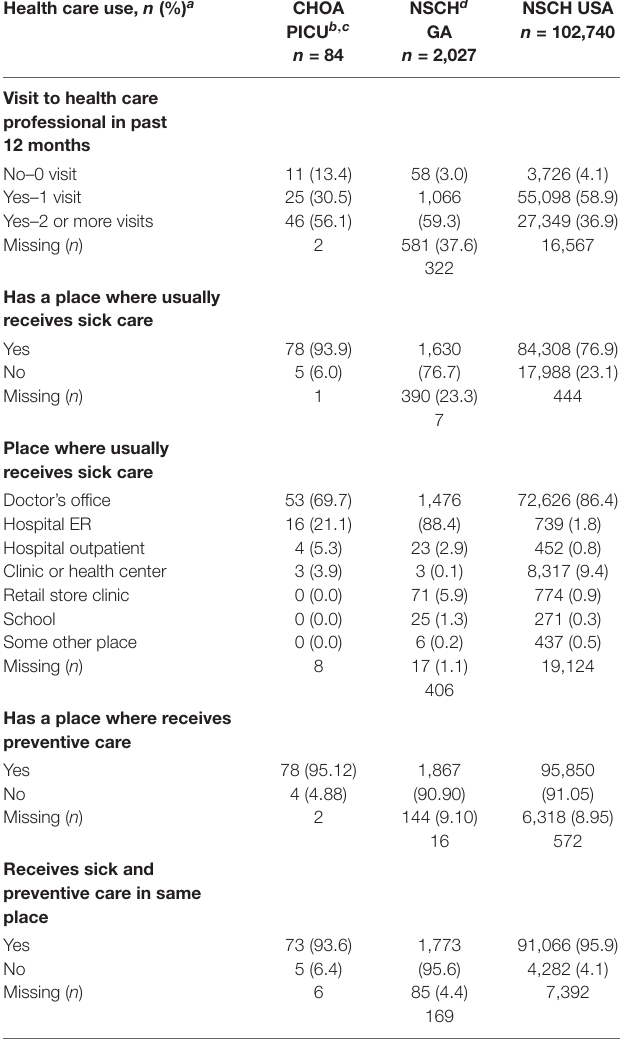
TABLE 2 | Healthcare use for the children admitted to the pediatric intensive care unit compared with the general pediatric population in georgia or the united states from the national survey of children’s health.